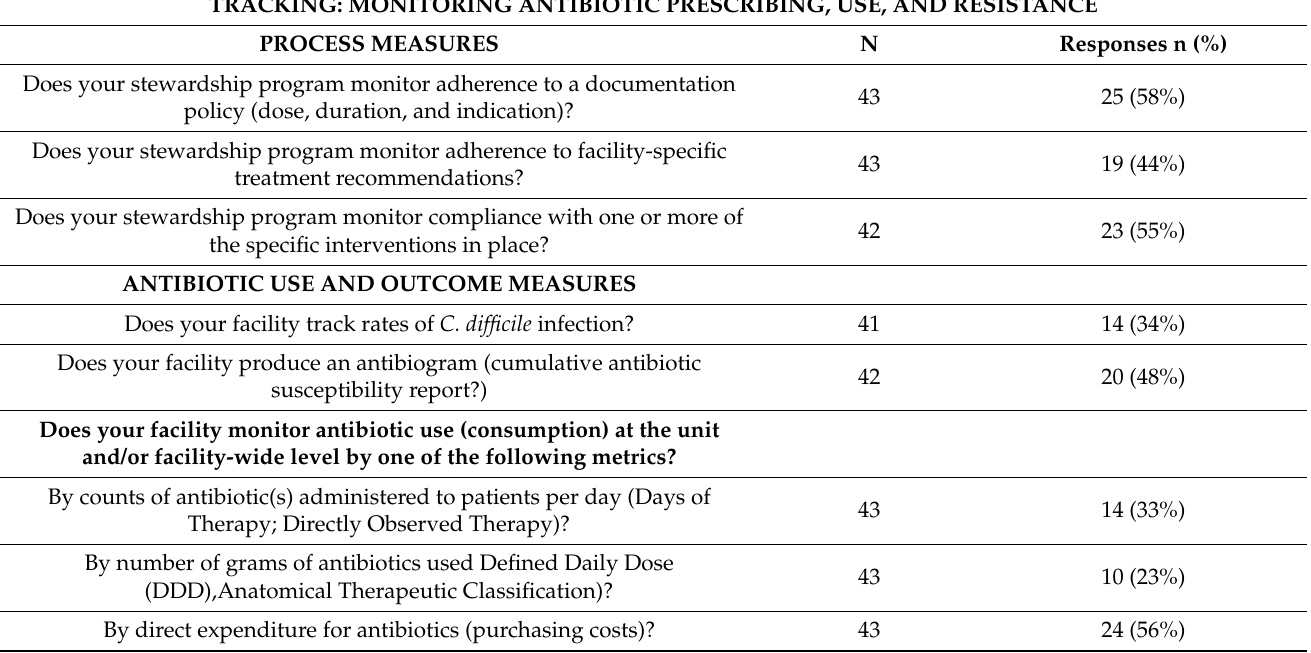
Table 4. Tracking: monitoring antibiotic prescribing, use, and